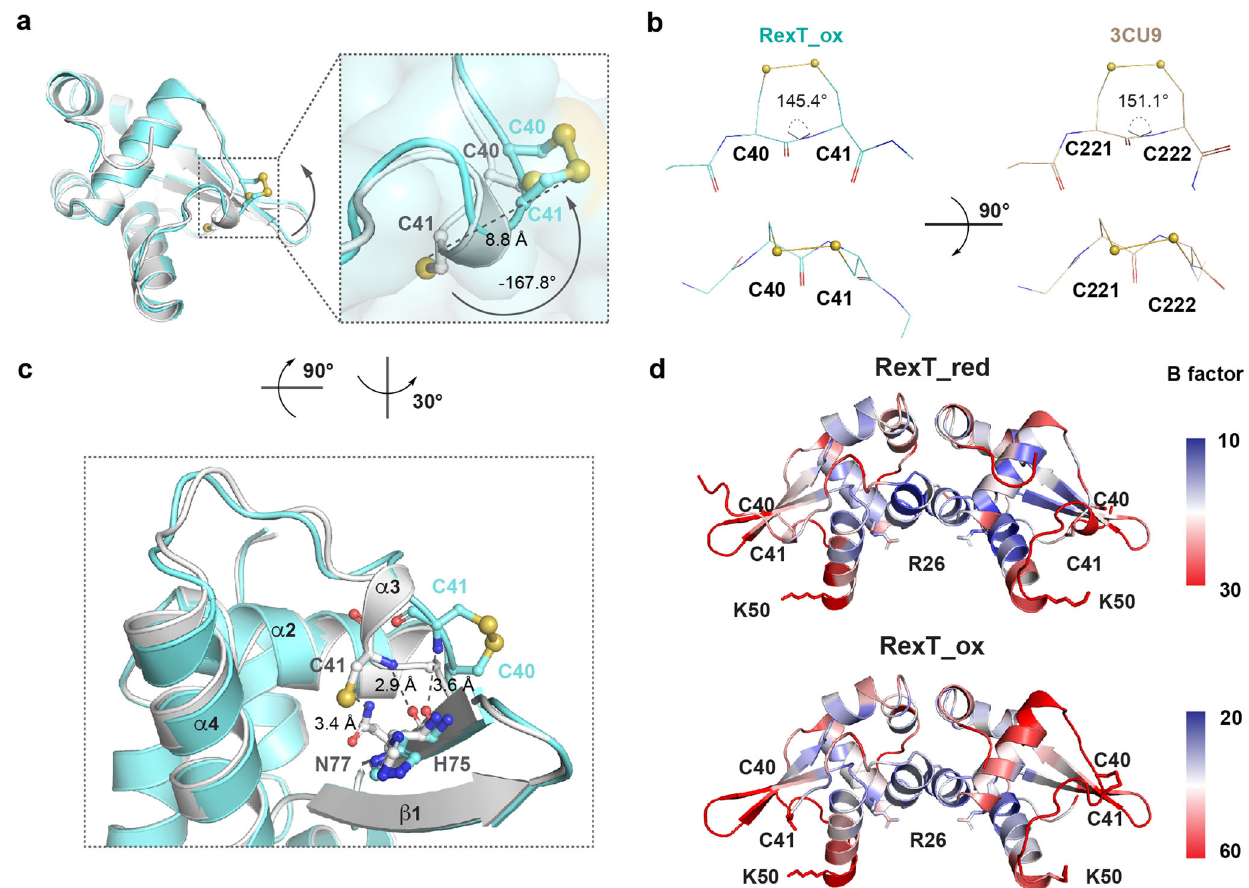
Fig. 4 Disul fi de bond formation in RexT causes a conformational change and loss of interactions. a An overlay of chain B from the structures of the reduced (light gray) and oxidized (teal) states of RexT. A box is included to highlight the Cys residues involved in disul fi de bond formation. The formation of the disul fi de bond requires Cys41 to undergo a large conformational change. b Comparison of the eight-membered vicinal disul fi de bond geometry in RexT and 1, 5-alpha-L-arabinanase 37 (PDB ID: 3CU9). The ω angles of both RexT and 1, 5-alpha-L-arabinanase show a large deviation from the ideal values. c Upon disul fi de bond formation in RexT, the movement of Cys41 causes disruptions in the interactions between the thiol-group and the sidechain of Asn77 as well as interactions between the Cys41 backbone amide and the backbone of His75. Both Asn77 and His75 are found in the wing portion of the wHTH motif involved in DNA binding. d The B factors of the reduced (top panel, RexT_red) and oxidized (bottom panel, RexT_ox) states of RexT are illustrated in a continuum from blue, white to red. Blue corresponds to a lower B factor and red represents a higher B factor. The reduced structure is colored on a scale from 10 to 30, whereas the oxidized structure is colored on a scale from 20 to